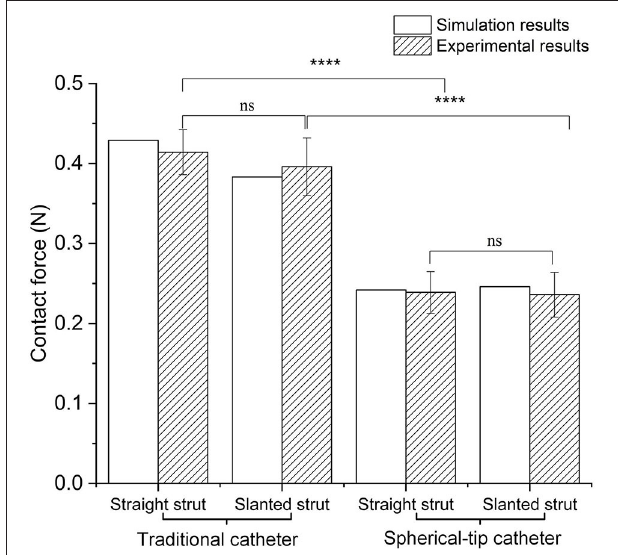
FIGURE 10 | Comparison of contact force between simulation and experimental results under traditional/spherical-tip catheter groups and straight/slanted strut groups. **** p < 0.0001, ns, not